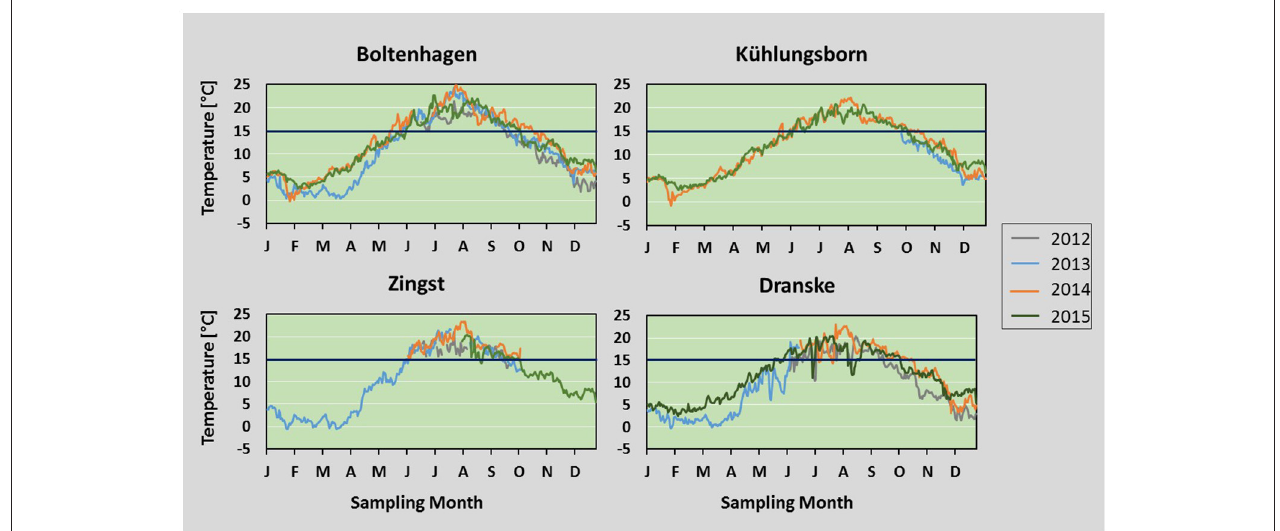
FIGURE 4 | Temperature: Daily mean temperatures measured from 2012 to 2015 at Boltenhagen, Kühlungsborn, Zingst, and Dranske. Values are based on hourly measurement intervals. The dark-blue line indicates the presumed lower threshold of 15 ◦ C for the start of Teredo navalis reproduction.